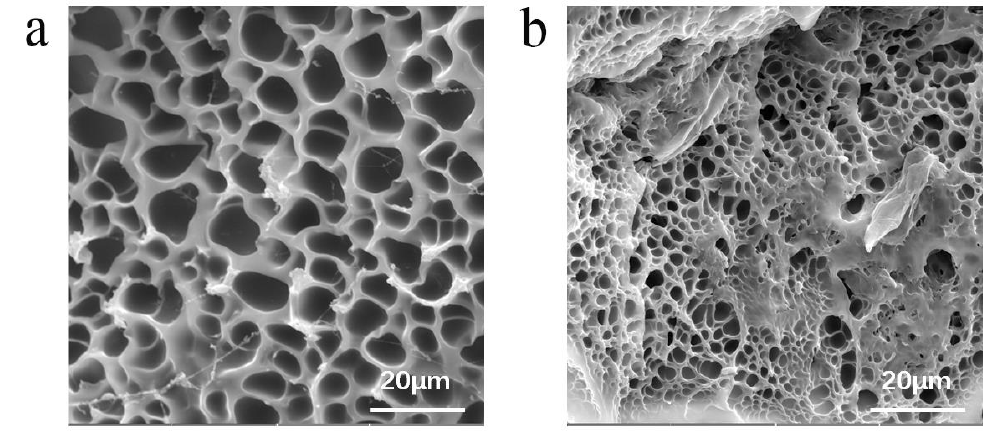
Figure 3. SEM images of ( a ) PAA hydrogels and ( b ) P(AA-HEMA)/GO hydrogels.